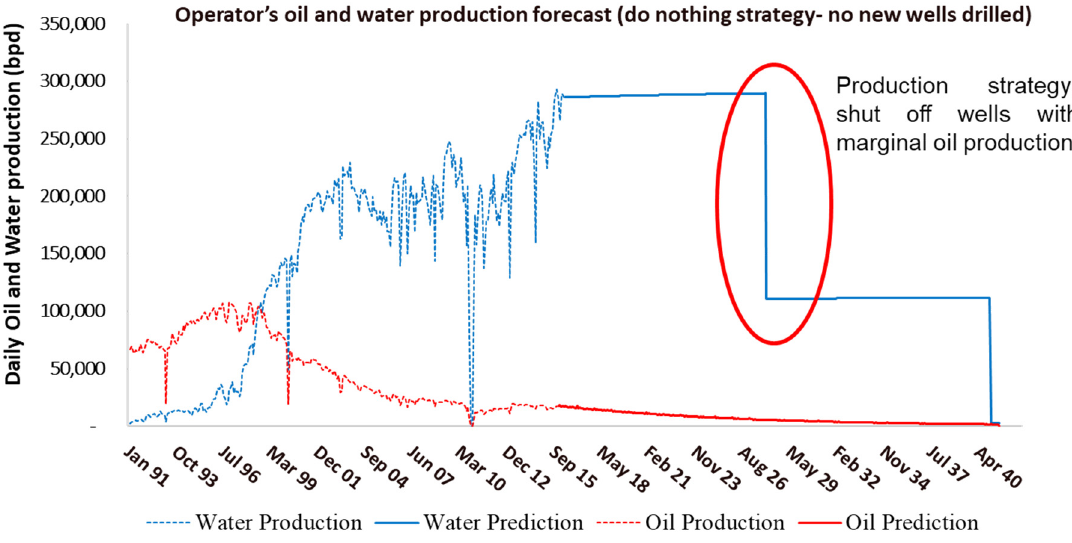
Figure 9. Possible future water production profile for the Wytch Farm field involving stepping down in output, from